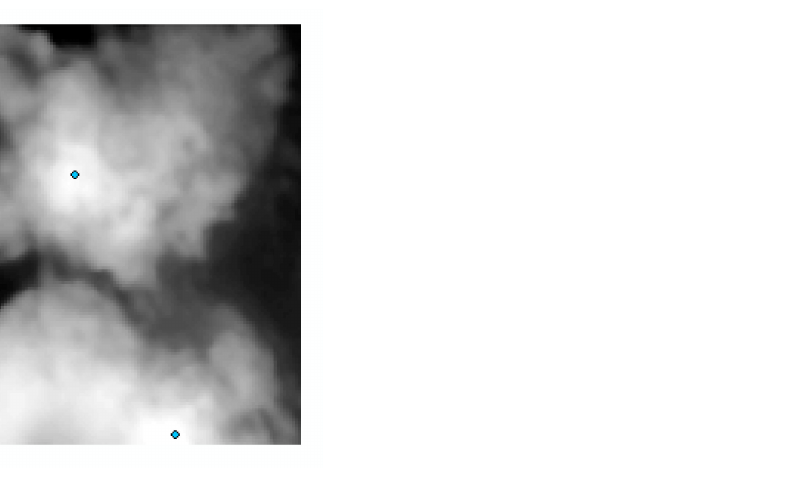
Figure 29. The distribution map of the sixth dataset extracted using the reference method.